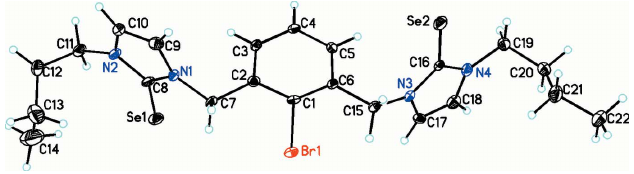
Figure 1 The molecular structure of the title compound, with the atom labelling. Displacement ellipsoids are drawn at the 30% probability level. For the disordered n -butyl substituent (atoms C11–C14) only the major component is